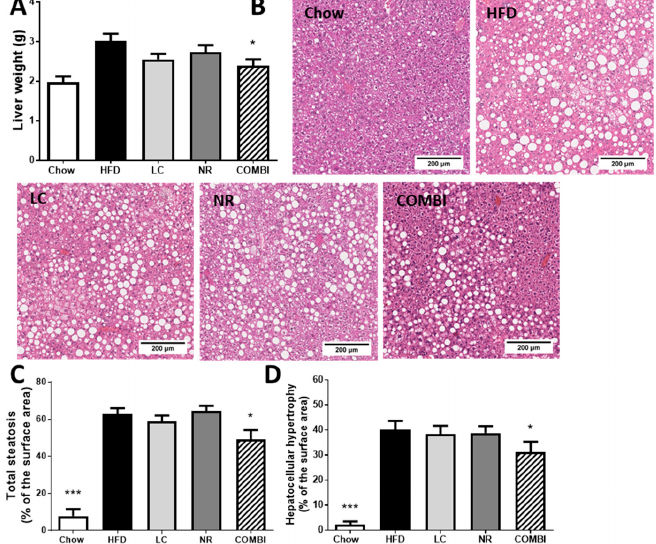
Figure 3. Liver analysis after 21 weeks of LC, NR and COMBI treatment. ( A ) Liver weight, ( B ) representative images of hematoxylin-eosin stained liver sections, ( C ) total steatosis, ( D ) hepatocellular hypertrophy. Data are presented as mean ± SEM, * p < 0.05 or ** p < 0.01 or *** p < 0.001 compared to the HFD control group.